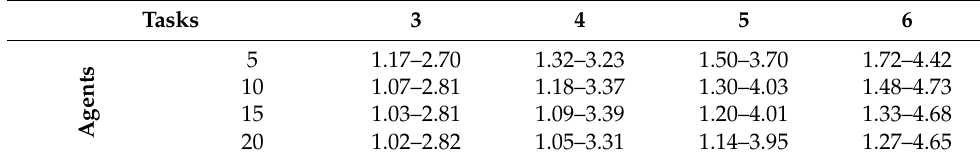
Table 7. Range of Reliability Improvement Factor (Scenario